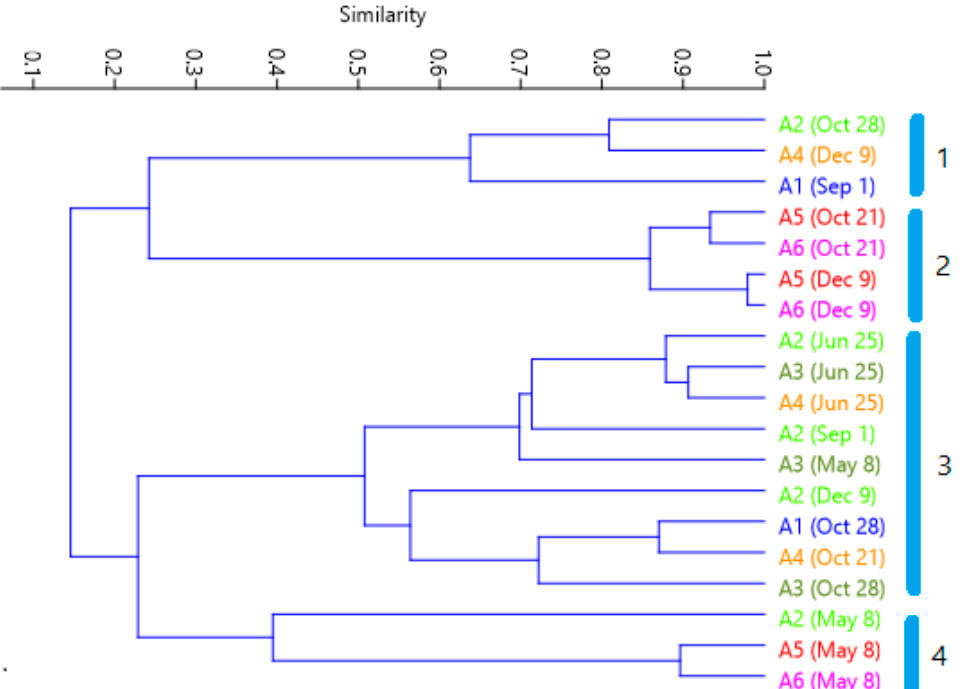
Figure 8. Cluster of correlations between site sampling points. Groups are labeled as 1 to 4. Each color corresponds to the same sampling site as Figure 1.